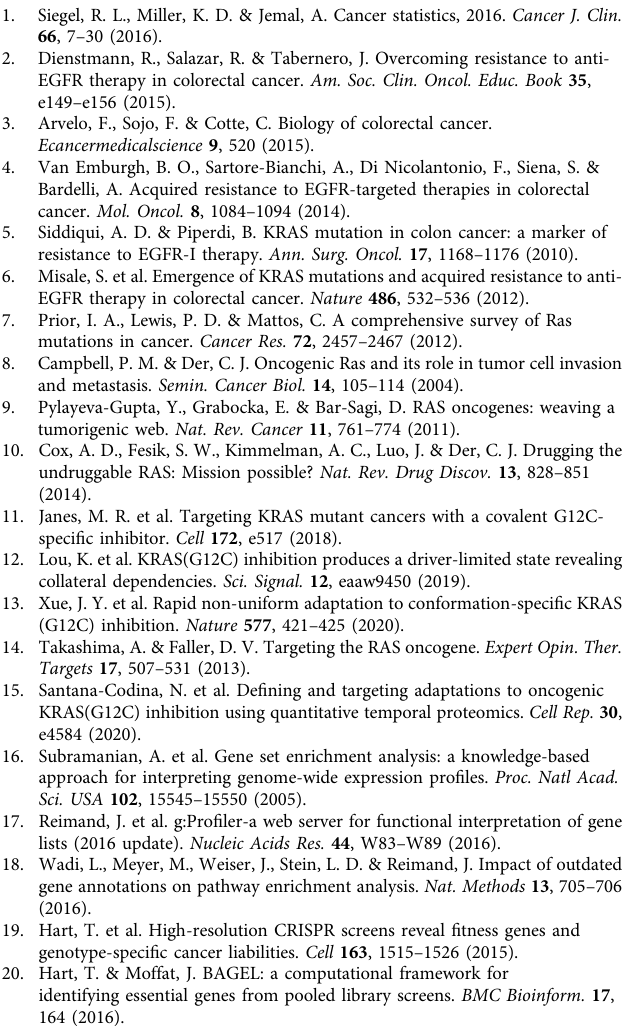
Supplementary Fig. 1a are available from cBioportal (https://www.cbioportal.org/study/ summary?id = coadread_tcga_pan_can_atlas_2018). GSEA graphs presented in Fig. 1b and supplementary data Fig. 1e are available at https://www.gsea-msigdb.org/gsea/ msigdb/cards/HALLMARK_KRAS_SIGNALING_UP and